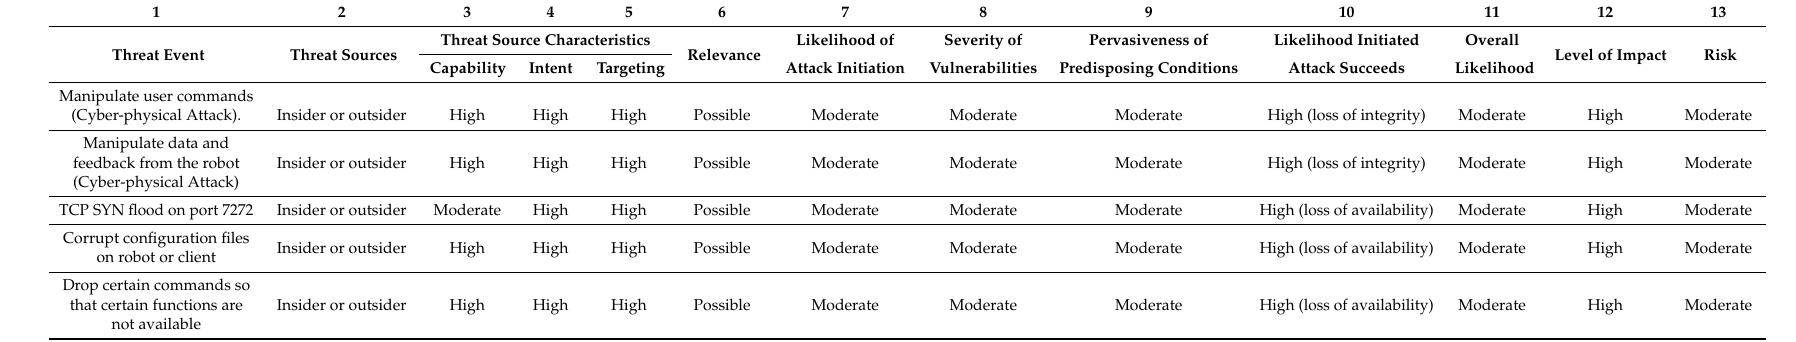
Table 1. Risk assessment